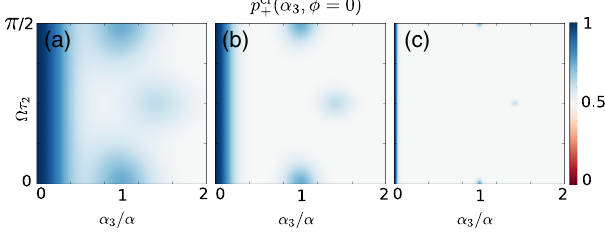
FIG. 7. Probability p of finding the qubit in the excited state if þ the resonator were described by a classical probability distribu- tion using width σ ¼ 0 . 5 , 1, 5 from (a) to